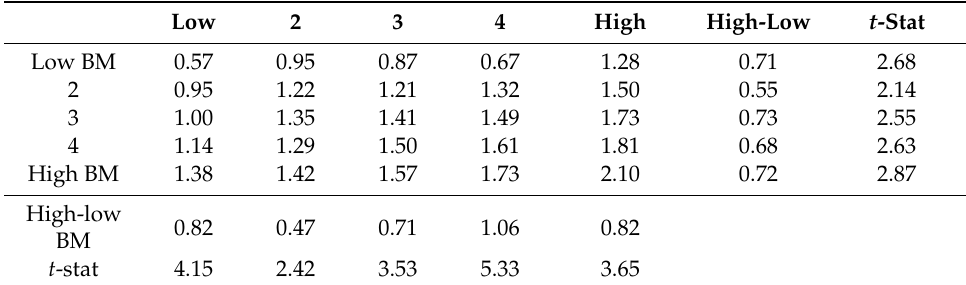
Table 16. Average returns from double-sorted quantile portfolios (sorted by book-to-market ratio and Geske’s short-term minus forward default probability). From the data for July 1963 to December 2013, at the end of each month, stocks are independently sorted into 5 × 5 portfolios based on book-to-market and Geske’s short-term minus forward default probability. The table shows average returns for each of 25 portfolios. Small-big is the return di ff erential between the small and big firm portfolios within each default quantile. High-low is the return di ff erential between the high and low default probability firms within each size quantile. t -statistics are calculated using Newey-West standard